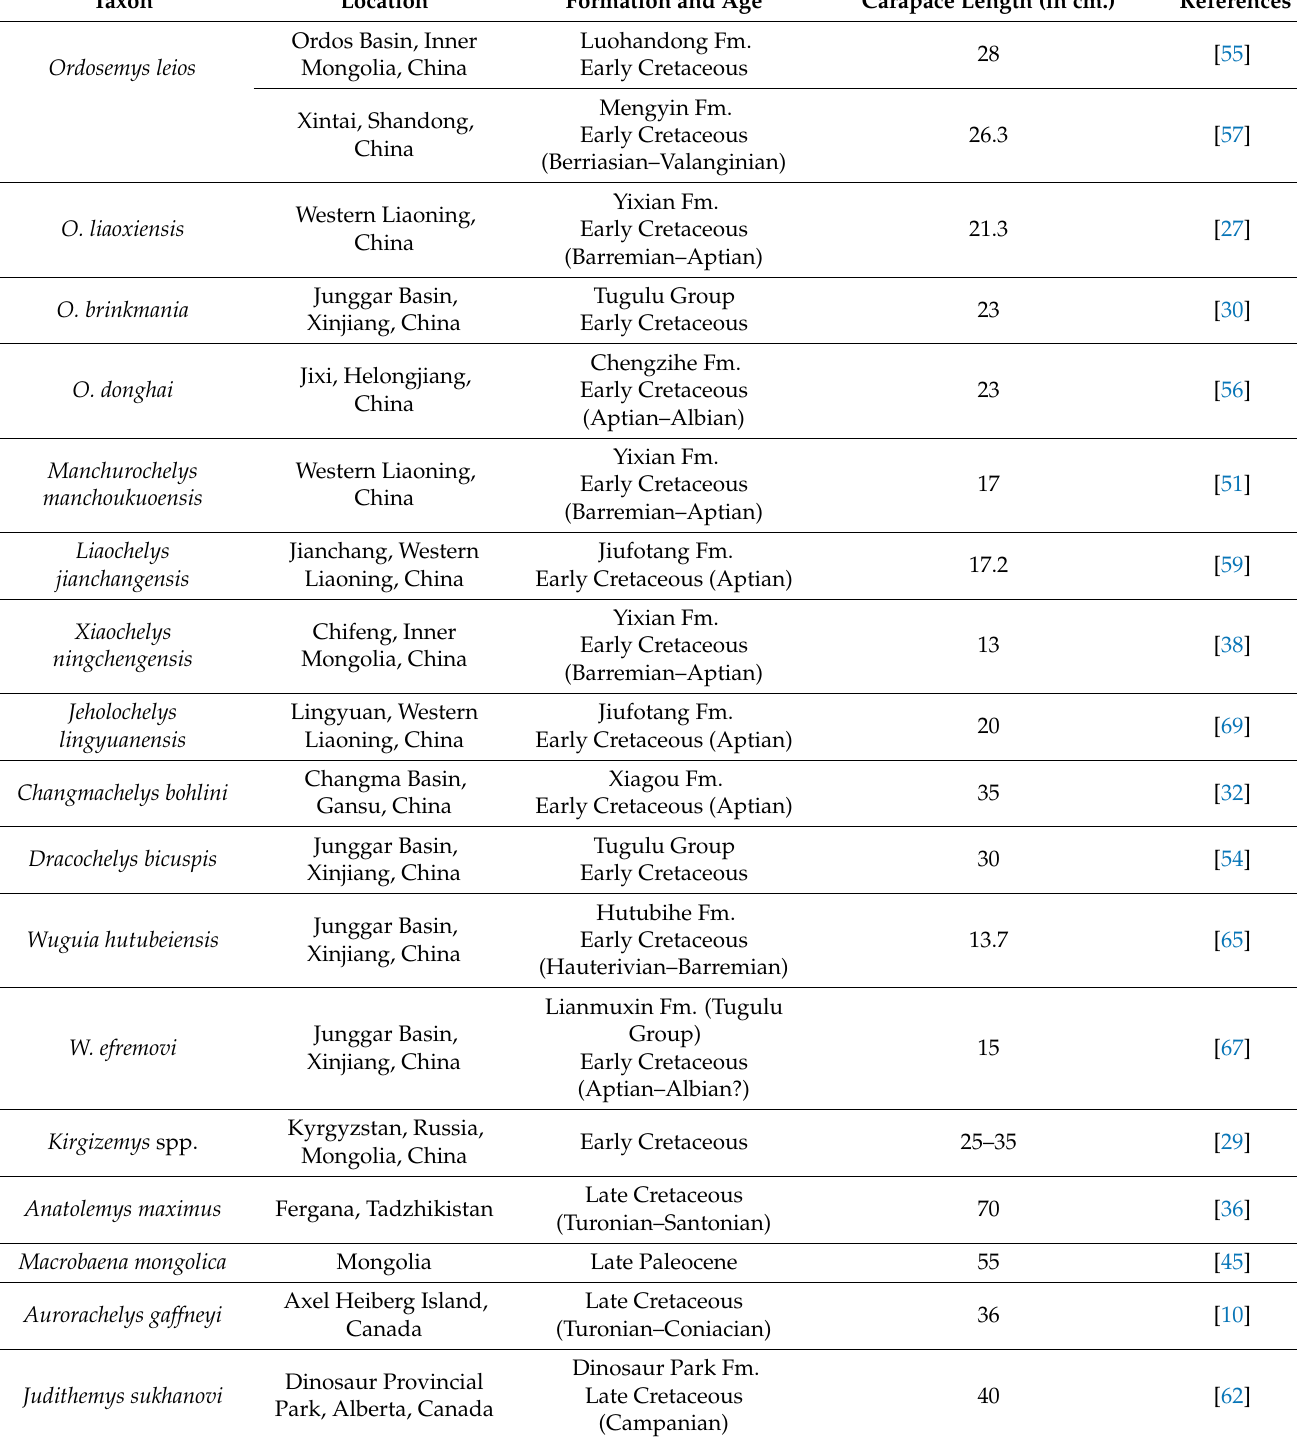
Table 1. Size of